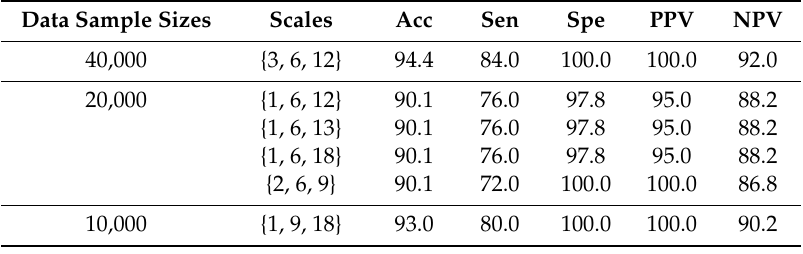
Table 4. List of combinations of three optimal MSE ( r = 0.15) scales for the discrimination between older NSR and CHF participants using LDA, as well as the corresponding accuracy, sensitivity, specificity, positive predictive value, and negative predictive